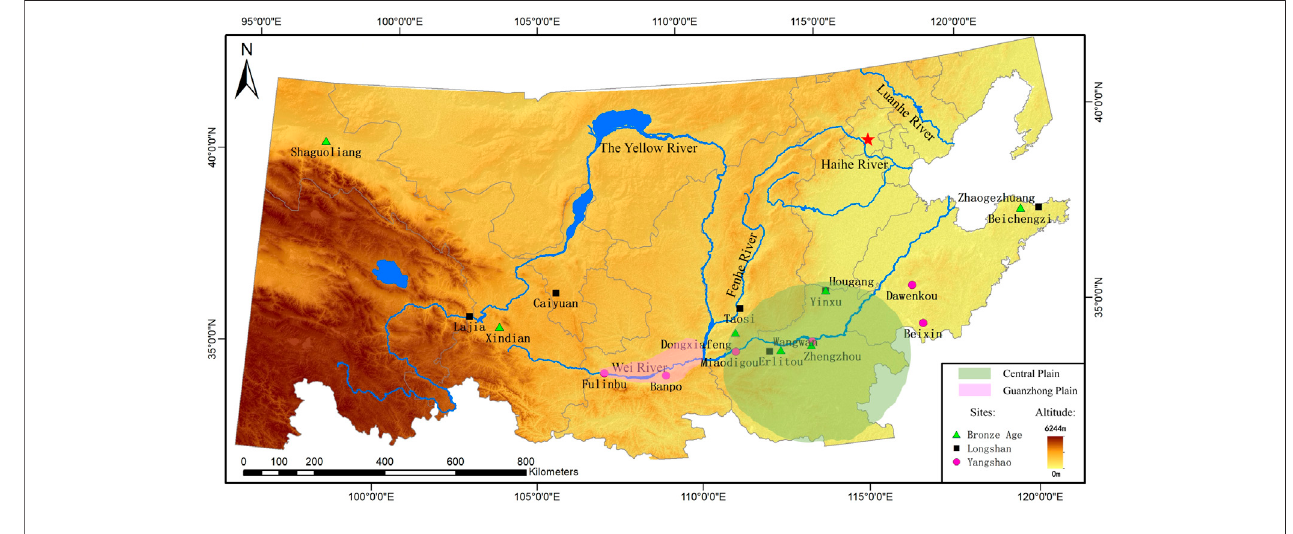
Frontiers in Earth Science |